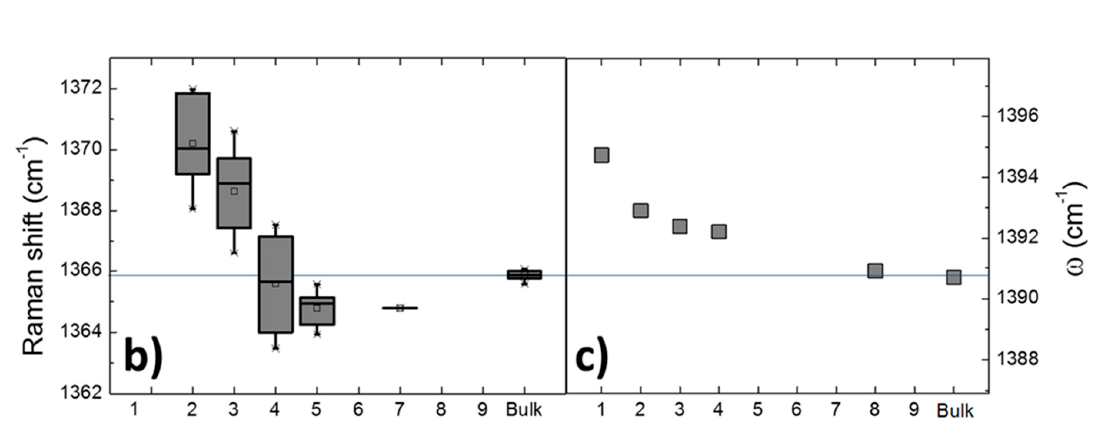
Figure S1: Relative spectral sensitivity of RGB Bayers filters and spectral windows of the bandpass filters